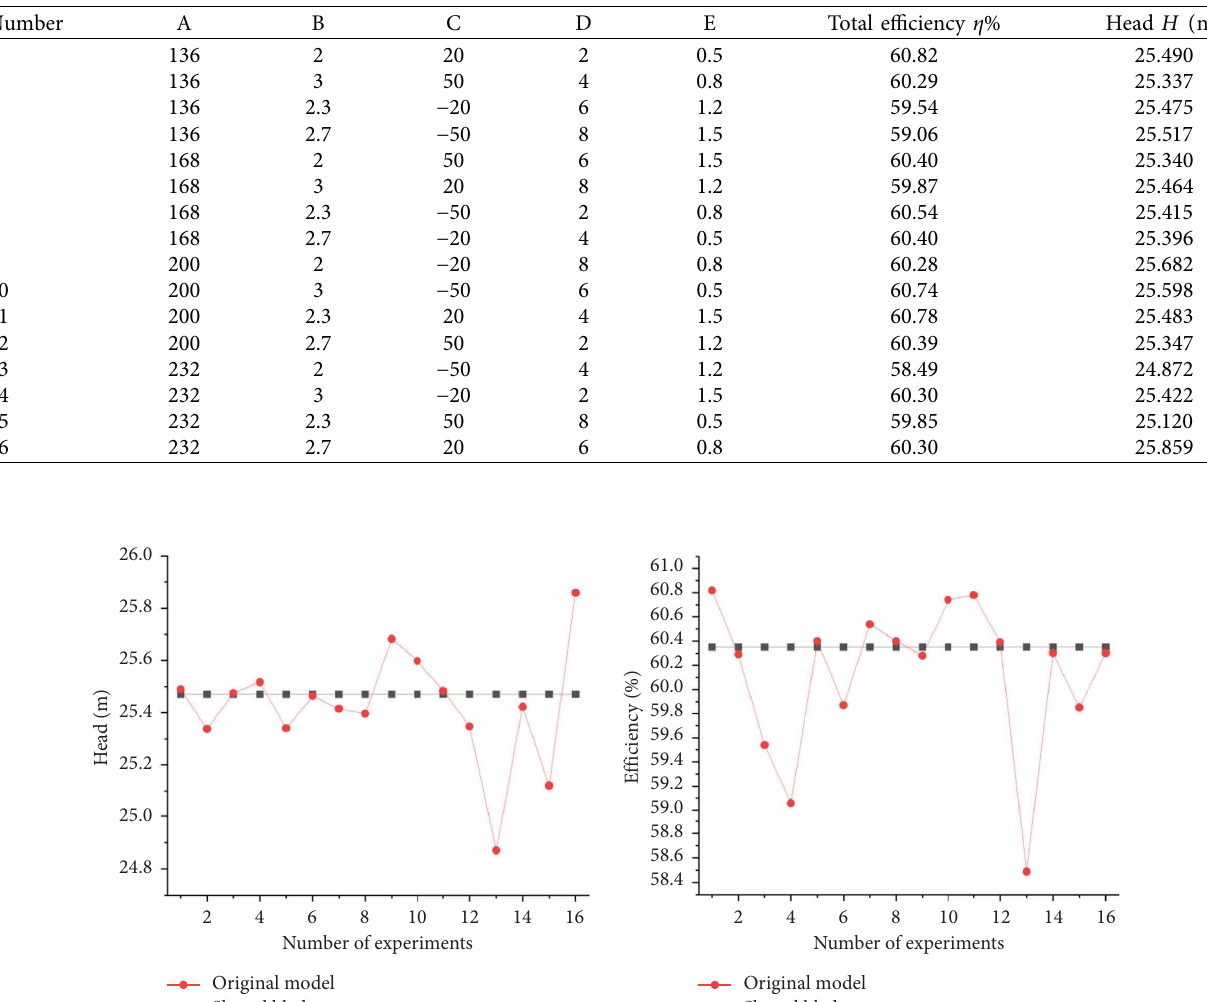
Figure 9: Slit watershed shape diagram: (a) Group 1; (b) Group 7; (c) Group 9; (d) Group Table 5: Orthogonal experiment data table.